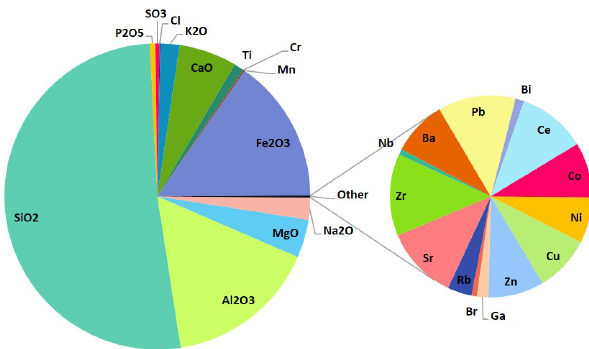
Figure 3. Average inorganic composition proportion of cryoconite samples G1 to G14 from XRF analysis. Note that these elements make up ∼ 70% of the composition of each